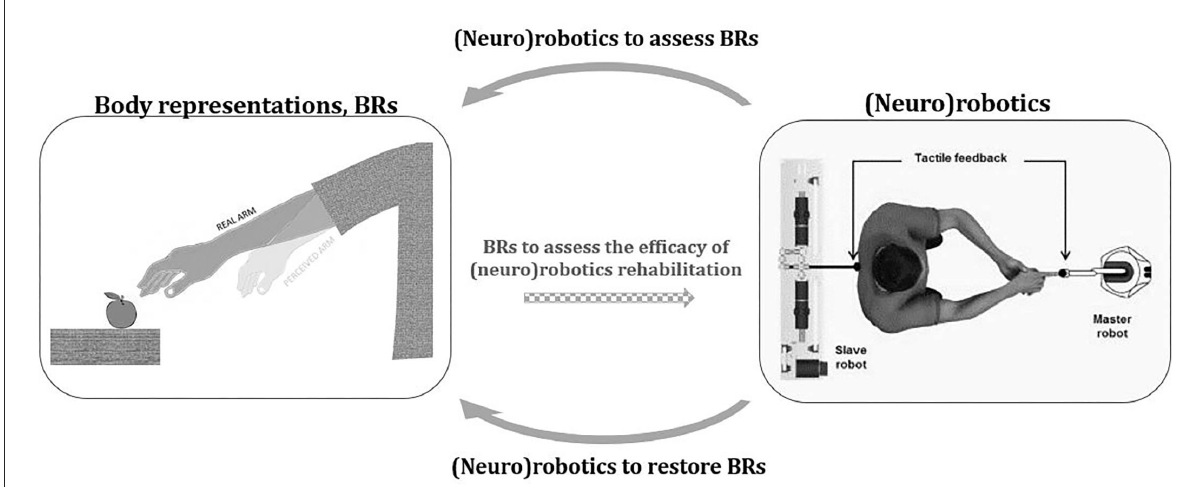
FIGURE1 Interaction between body representations and (neuro)robotics. The figure represents the potential contribution of (neuro)robotics to the field of body representations (BR). (Neuro)robotics might enhance the study of BRs by improving experimental rigor and by allowing new empirical conditions that would be difficult to achieve without technological automation and control (top arrow). By providing controlled and precise somatosensory stimuli, also in combination with other technologies (e.g., virtual reality), (neuro)robotics may offer a significant contribution to the modulation of distorted BRs (bottom arrow). In this new perspective, the ability of robotic devices to monitor and possibly treat BRs distortions could become one of the parameters to evaluate their effectiveness (central dotted arrow). The image on the right is modified with permission from Blanke et al.